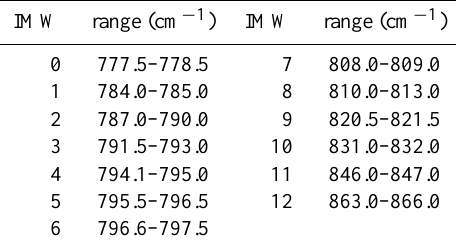
Table 1. A list of employed integrated microwindows and their spectral